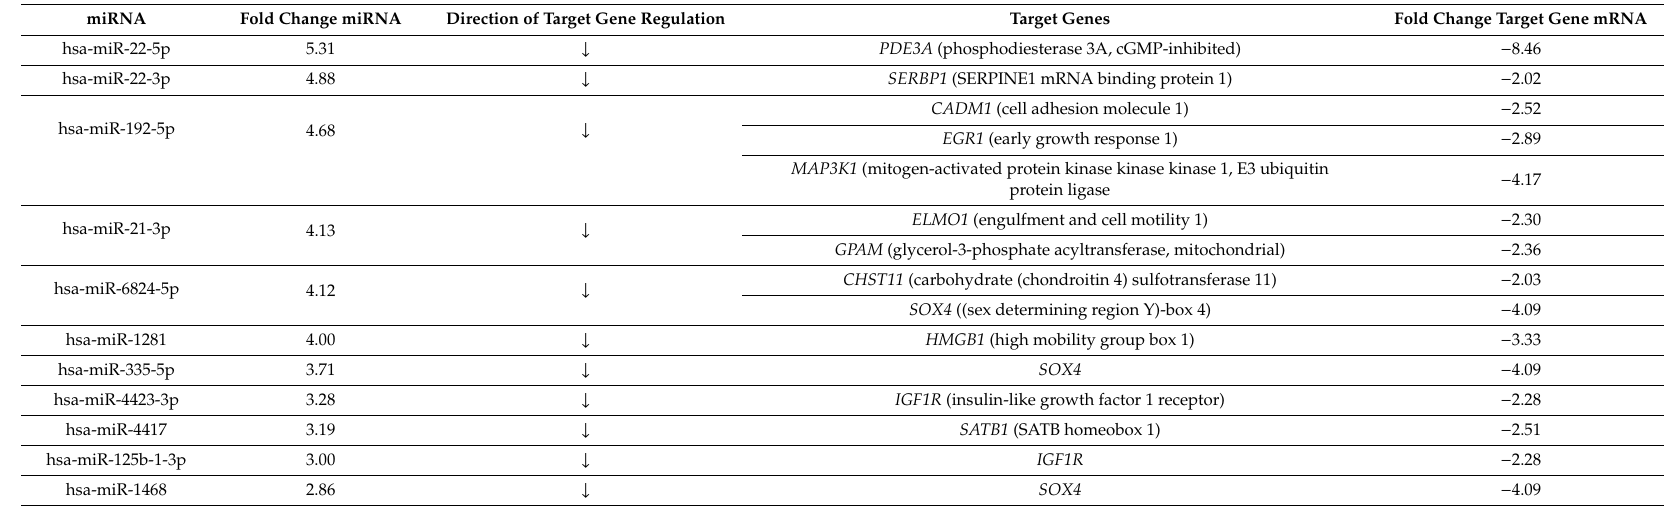
Table 9. The list of most dysregulated anti-apoptotic miRNAs with their targets, in bortezomib-treated SH-SY5Y cells compared to controls. Presented miRNAs downregulate expression of their target genes, hence the direction of target genes regulation is marked as “ ↓ ”. Since all miRNAs have increased expression (positive fold change), the downregulation of their targets is prominent and therefore they present with negative fold change, which indicates decreased expression of anti-apoptotic